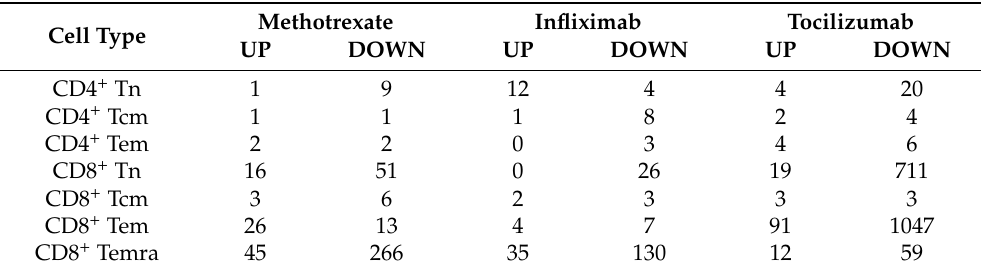
Table 3. Upregulated and downregulated genes of treated RA compared with untreated RA samples of T cell